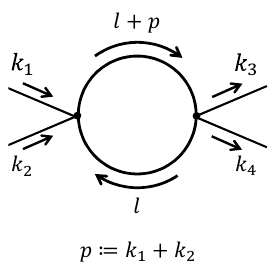
Figure 3 . The s -channel loop